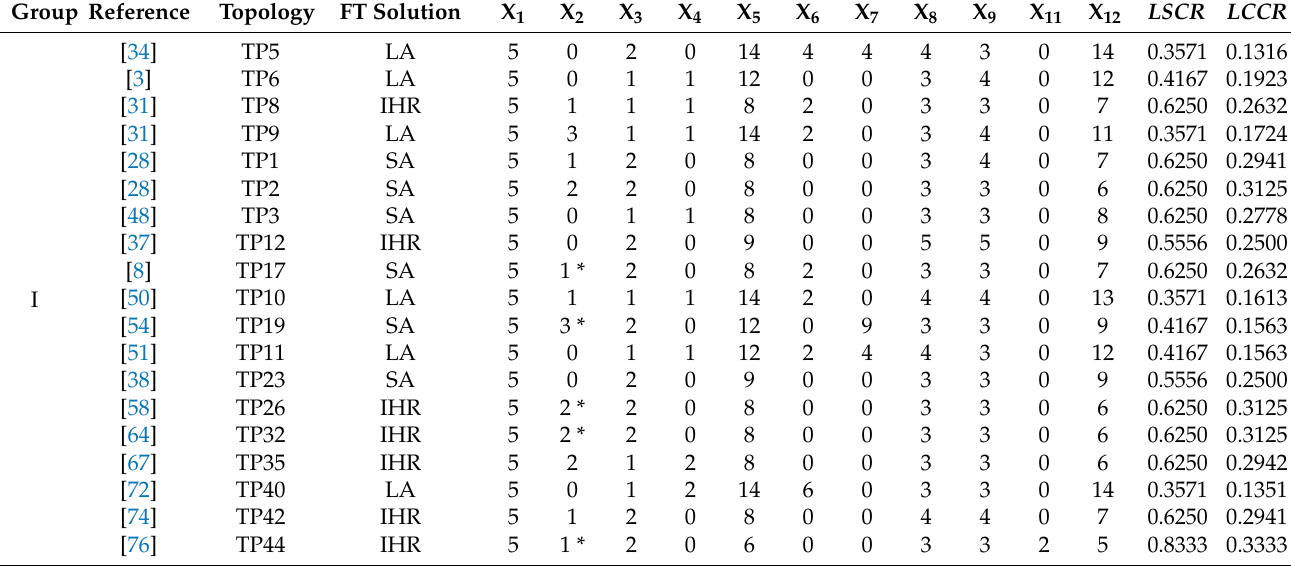
Table 1. Comparison of single-phase FT MLIs in terms of LSCR and LCCR